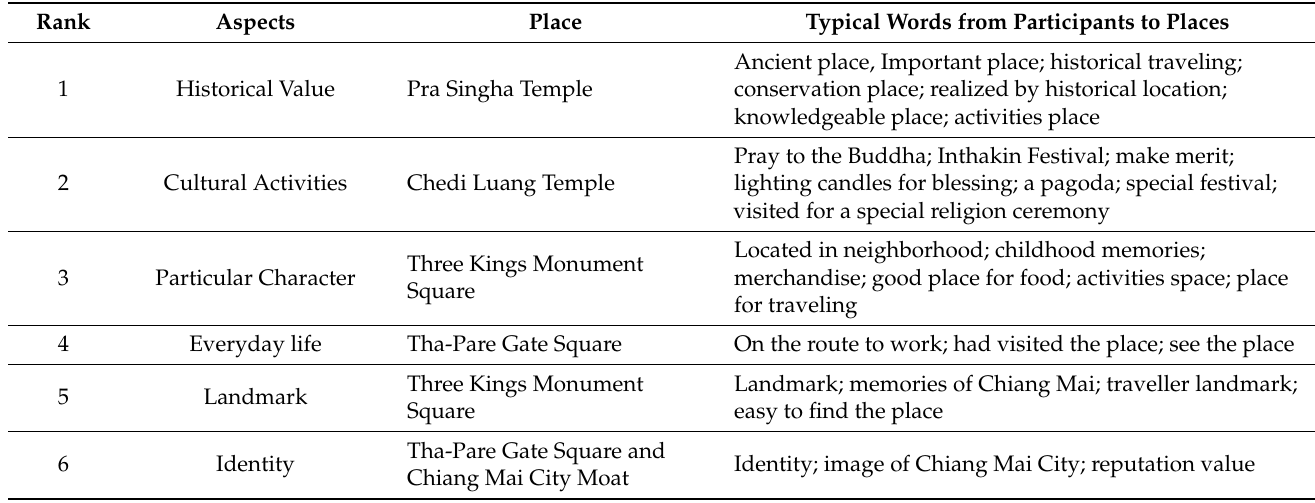
Table 7. The conclusion of the recollection to the important places in Chiang Mai Old